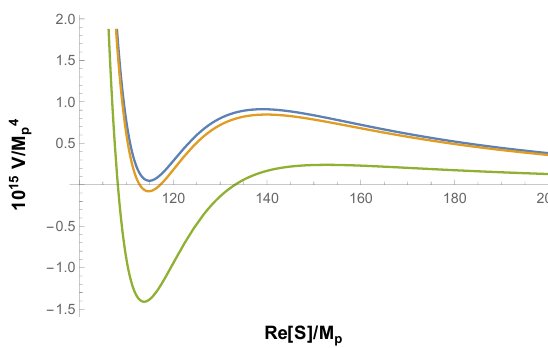
Figure 5 . The figure shows the KKLT potential for RG time t = 0 . 1 , 0 . 3 , 1 , using the parameter values A = 1 , a = 0 . 1 , W 0 = − 10 − 4 , P = 80 , ξ UV = 1 and with ( X , T ) restricted to their critical values. The potential at the critical point becomes negative as early as t ’ 0 . 3